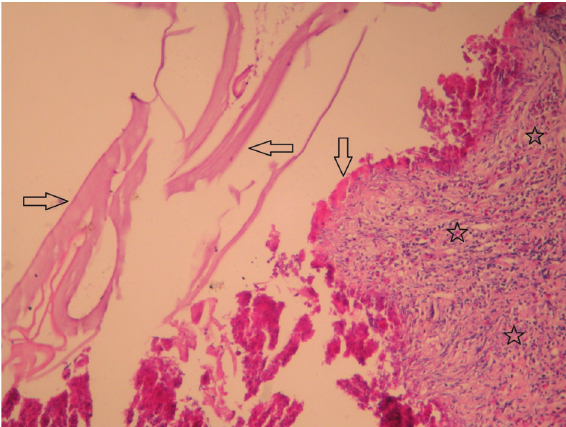
Figure 5: Hydatid cyst germinative membrane (right and left arrows), cuticular membrane (lower arrow), and inflammatory tissue rich of eosinophils (around stars) (H&E stain, ×